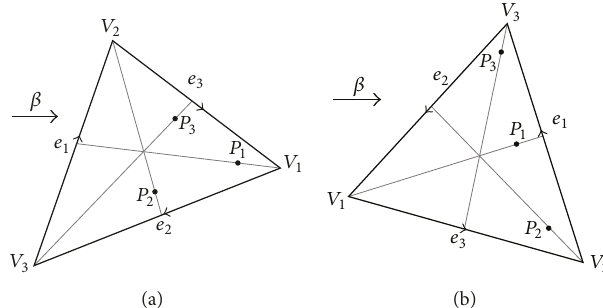
Figure 2: Configuration of internal nodes for convection-dominated regime: one inflow edge (a) and two inflow edges (b) (figure reproduced from [15] [under the Creative Commons Attribution License/public domain]).